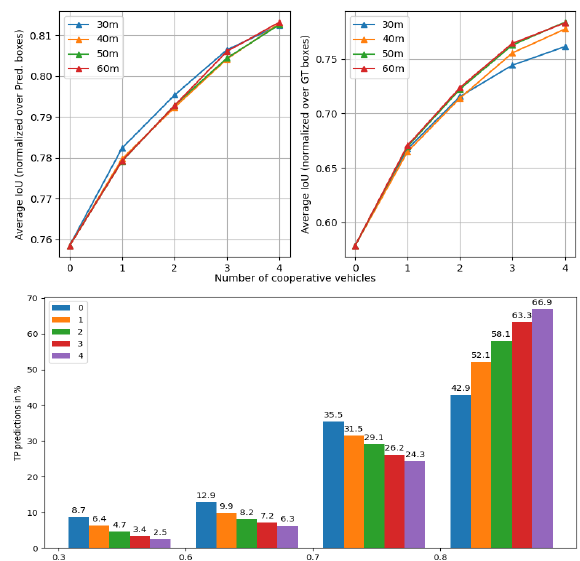
Figure 6. Influence of the number of cooperative vehicles and communication ranges on the localization accuracy (IoU) of pre- dicted bounding boxes. Top: average IoU of all positive predicted bounding boxes with ground truth, they are normalized over the number of all true positives (left) as well as all ground truths (right); Bottom: ratios of true positive predictions in different IoU intervals for communication range 50m means that the IoU of a detected object is less probable to be under 0.8 when increasing observing vehicles.